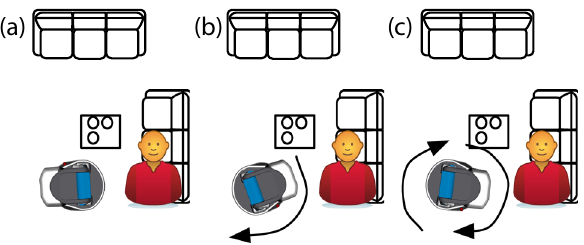
Figure 3: Example of the recovery procedure when Fetch traveled from Position 3 to Position 1. In ( a ) , Fetch is at Position 3 and has received the cup. Then, it rotates to go to Position 1 ( b ) . Once the rotation fi nishes, it tries to compute the route to Position 1. If this takes longer than 25 s, Fetch is considered “ stuck ” and rotates ∘ 360 to get unstuck ( c ) before continuing on its